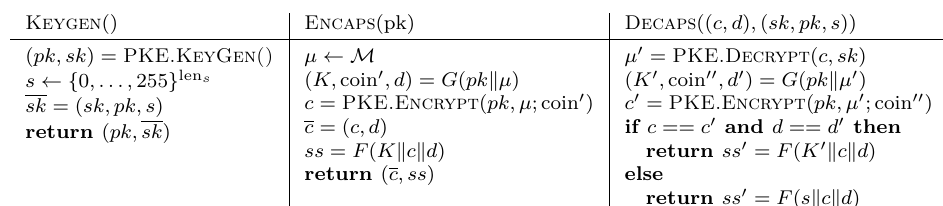
0 built using public key encryption scheme PKE m